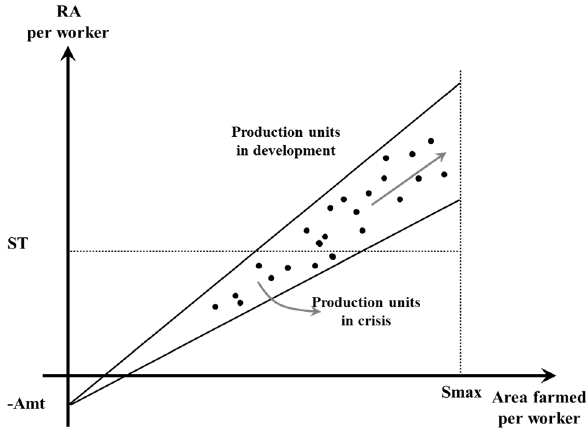
Figure 5. Production units in development and production units in crisis within the same agrarian system (adapted from [2]).